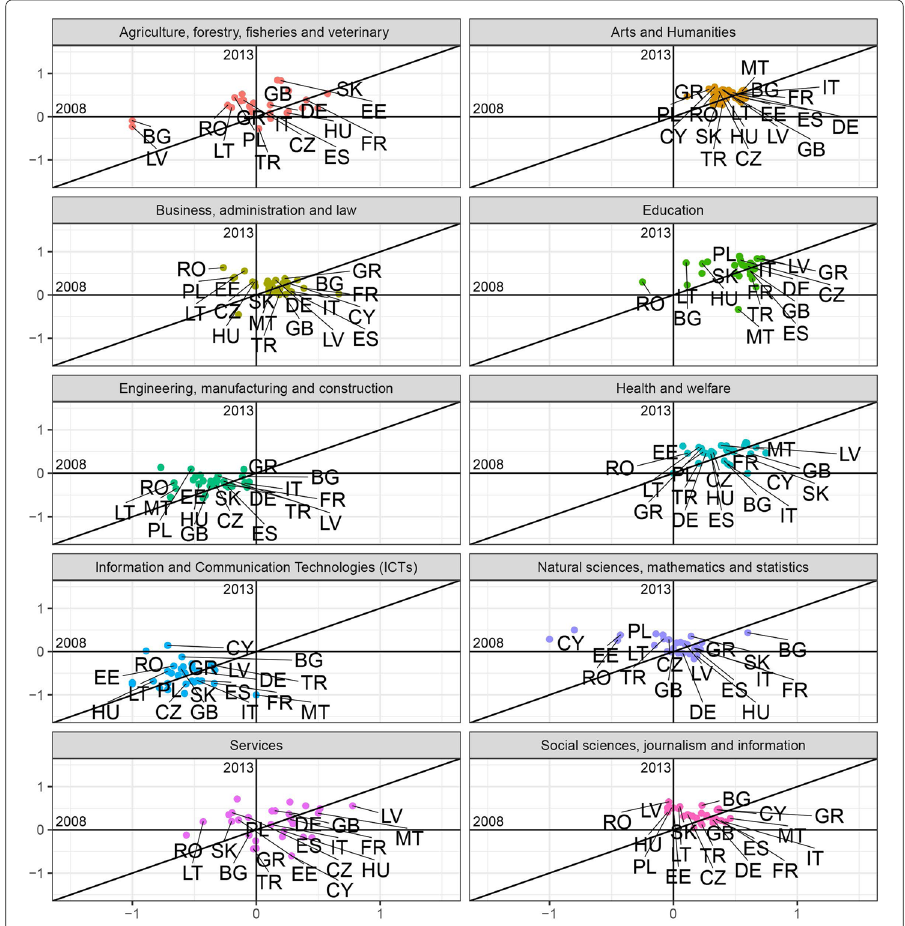
Fig. 4 Gender balance in the outgoing flows across fields of study for the year 2008 against 2013. The scatter plots show the F / M B measure for the outgoing flows of students for the years 2008 and 2013 for ten fields of study corresponding to the ISCED-F 2013 classification. Two macro fields ( Notknownorunspecified and Genericprogramsandqualifications ) are not showed. The label of the following countries are not displayed to improve readability: Austria (AT), Belgium (BE), Croatia (HR), Denmark (DK), Finland (FI), Iceland (IS), Ireland (IE), Liechtenstein (LI), Luxembourg (LU), North Macedonia (MK), Norway (NO), Portugal (PT), Slovenia (SI), Sweden (SE), Switzerland (CH), The Netherlands (NL). Note that the axes have the same scale limits, although the visual projection could appear